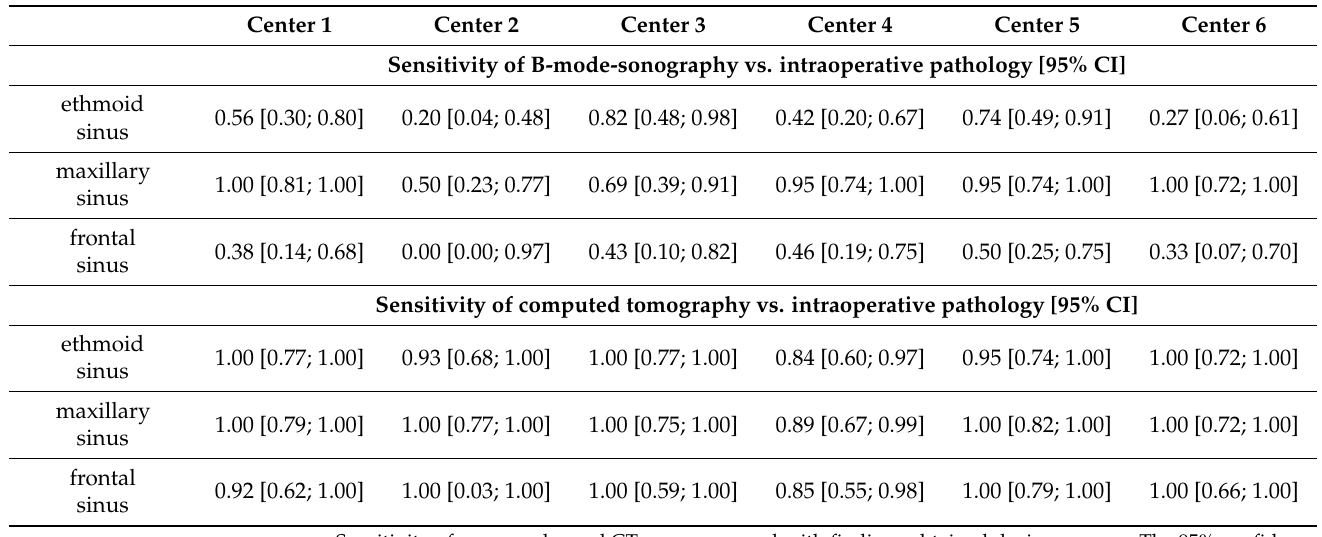
Table 4. Center comparison of B-scan US and CT assessment of pathology compared to the intraoper- ative